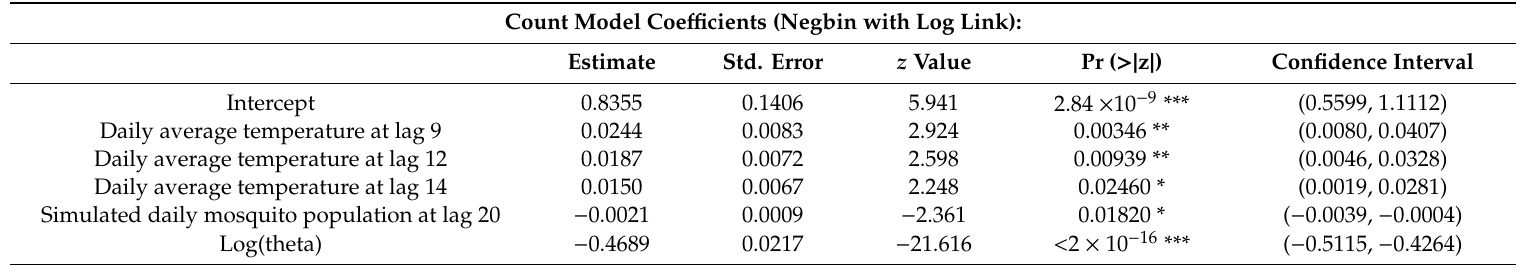
Table 2. Estimates of zero-inflated negative binomial regression model for Vhembe district municipality. Count Model Coe ffi cients (Negbin with Log